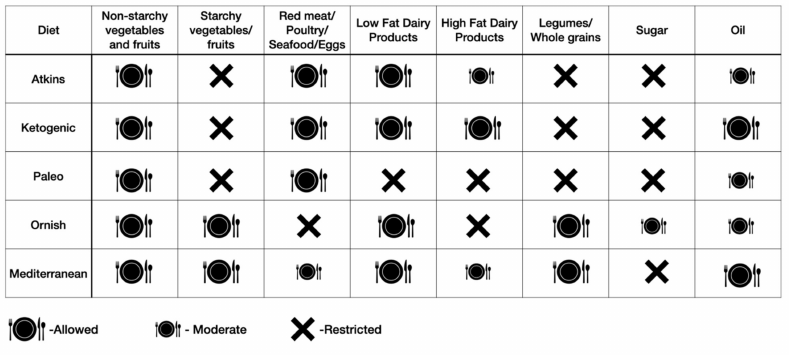
Figure 4. Popular dietary approaches for obesity based on inclusion and exclusion of specific food groups.